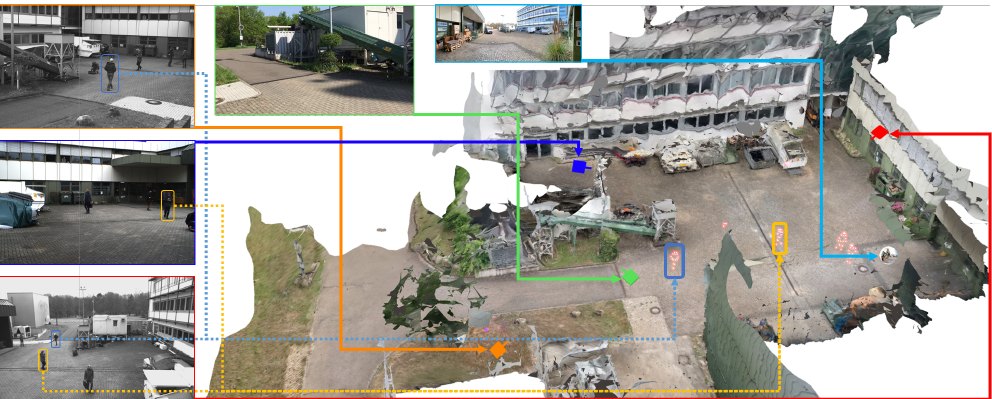
Figure 12. Multiple data sources are bundled and displayed simultaneously in a shared context. On the left side, three frames from static surveillance cameras are displayed. Their locations are indicated by small camera icons in the 3D scene (orange, blue, and red). Detections from all cameras are displayed simultaneously in the scene (dashed lines) as well as static material, such as photos (light green) and panoramic images